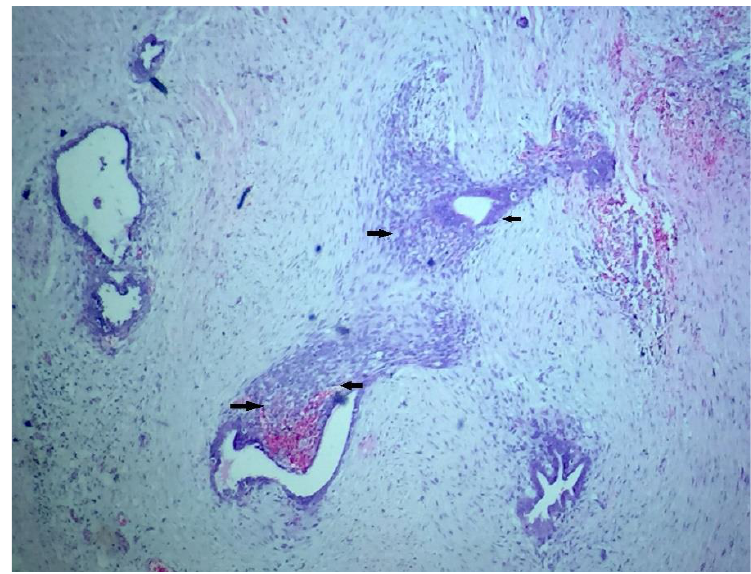
Figure 5. (H&E stain × 60): High-power view showing the scattered endometrial glands and stroma.